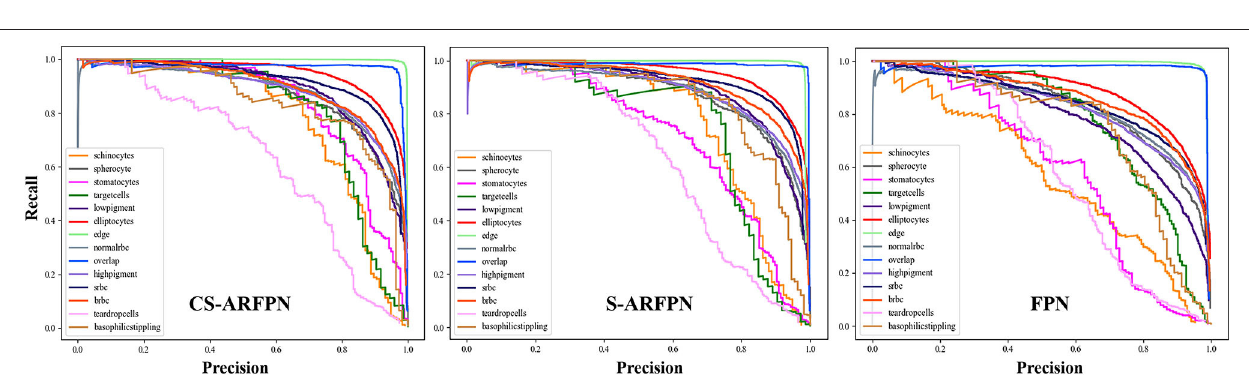
FIGURE 8 | Precision-Recall (PR) curve of the cell classification results. Different colored PR curves represent different types of RBCs. The closer the curved surface is to the upper right, the better the classification effect of the red blood cell.